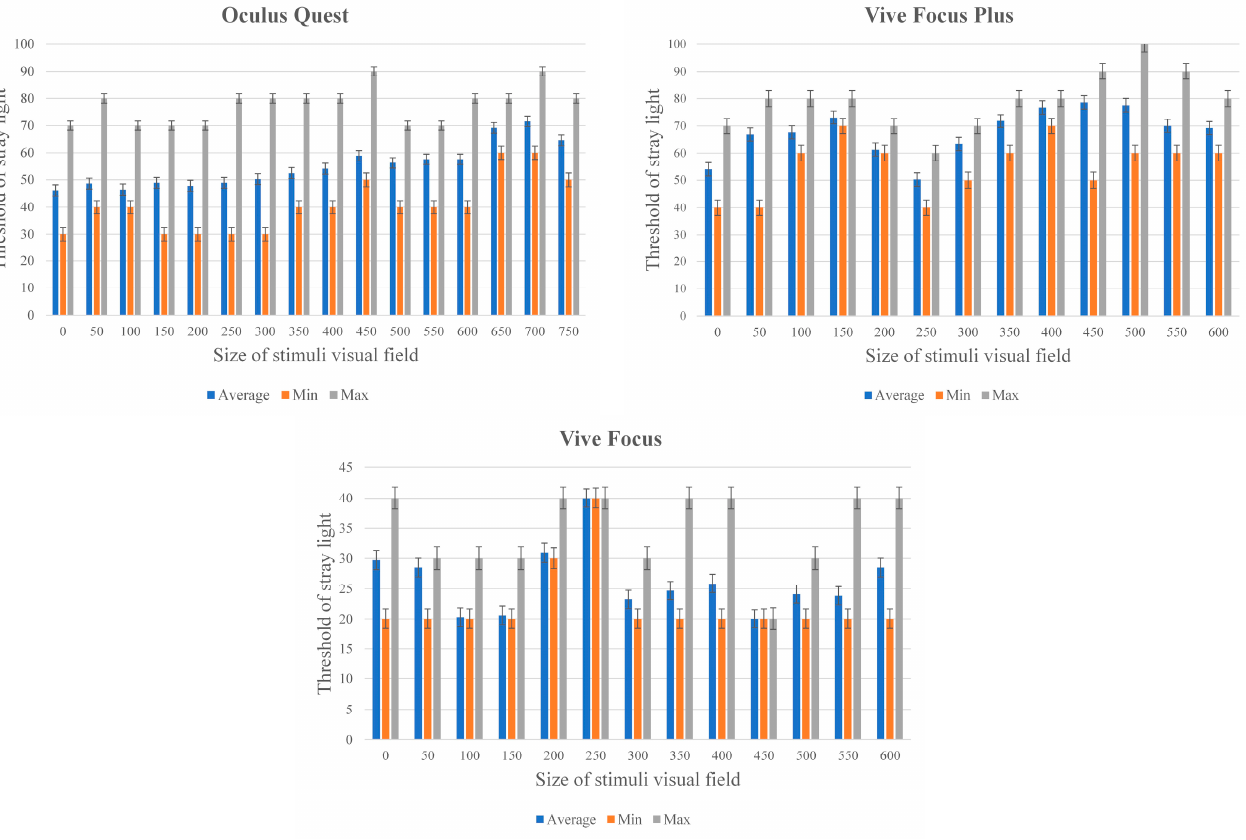
Figure 7. Stray light threshold of three VR HMDs